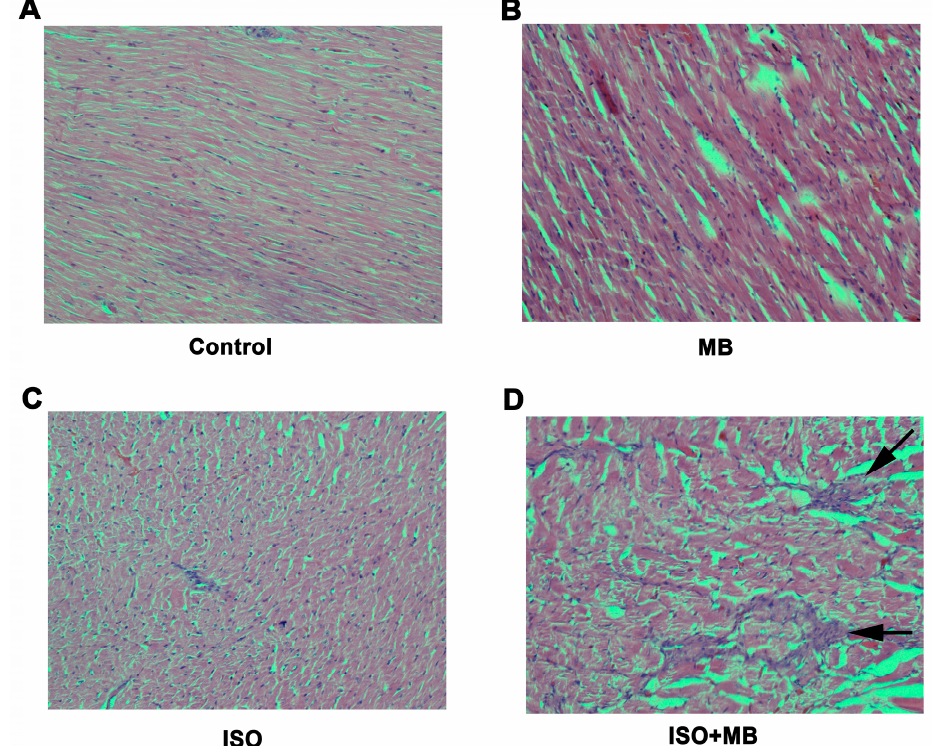
Figure 3. Histological analysis of myocardial injury. Histomicrograph of transverse sections of the heart [ × 200; hematoxylin and eosin stain] taken through the ventricles, just below the atrioventricular valves of control ( A ), 100 mg/Kg MB alone ( B ), ISO treatment alone ( C ), ISO + MB ( D ). The ISO group showed myocardial infarction in the central region of the left ventricular muscle wall ( C ). The Control ( A ) and MB only group ( B ) displayed no features of myocardial injury. The arrows demonstrated the area of fibrosis.